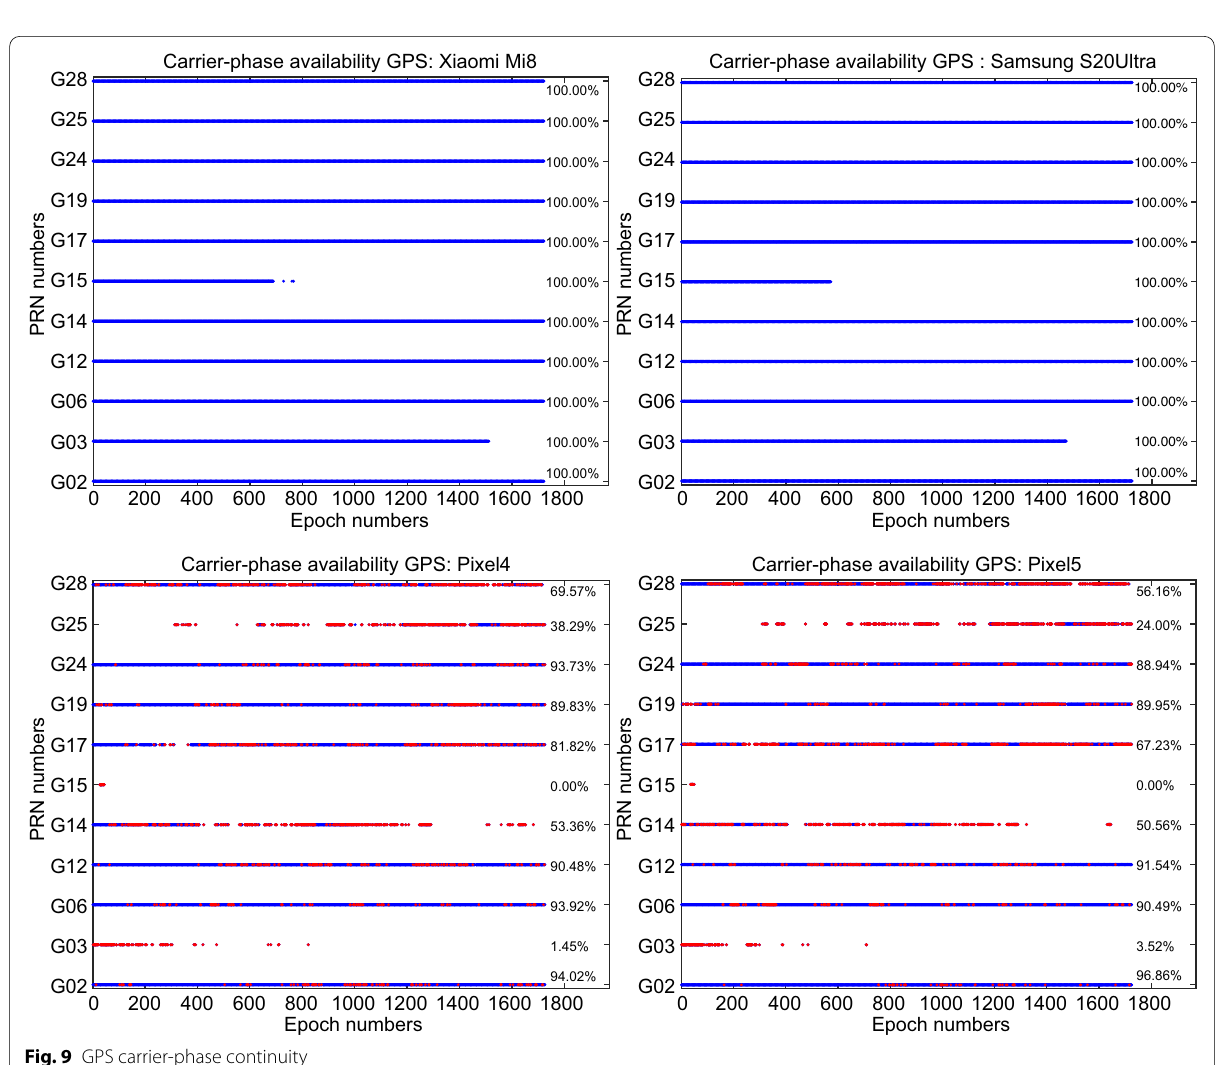
Fig. 9 GPS carrier-phase